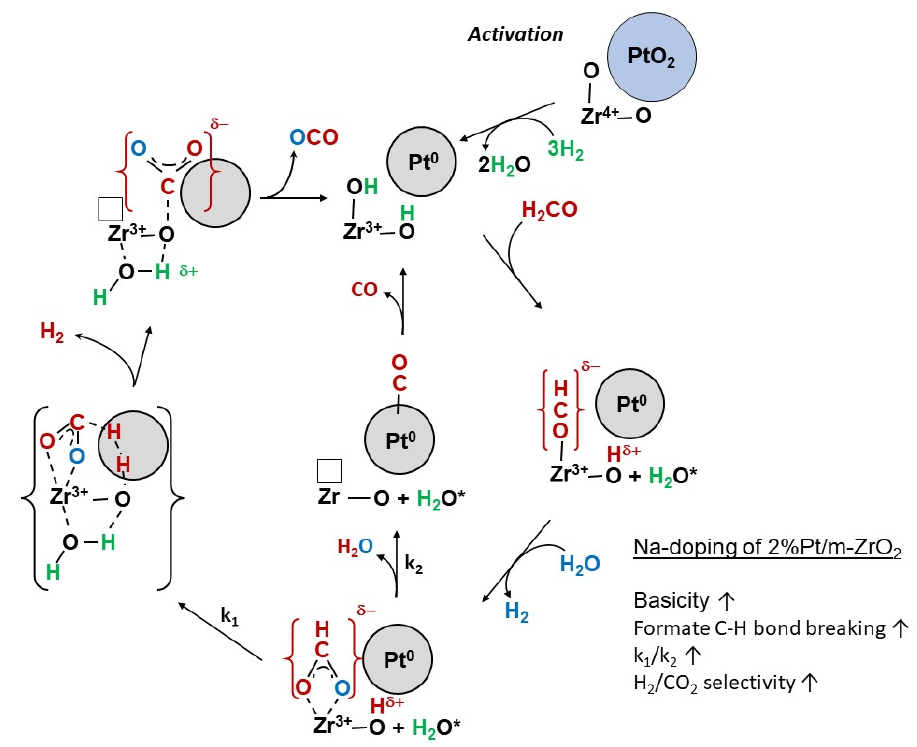
Figure 7. DRIFTS of steam reforming of formaldehyde over 5%Na-2%Pt/m-ZrO 2 .